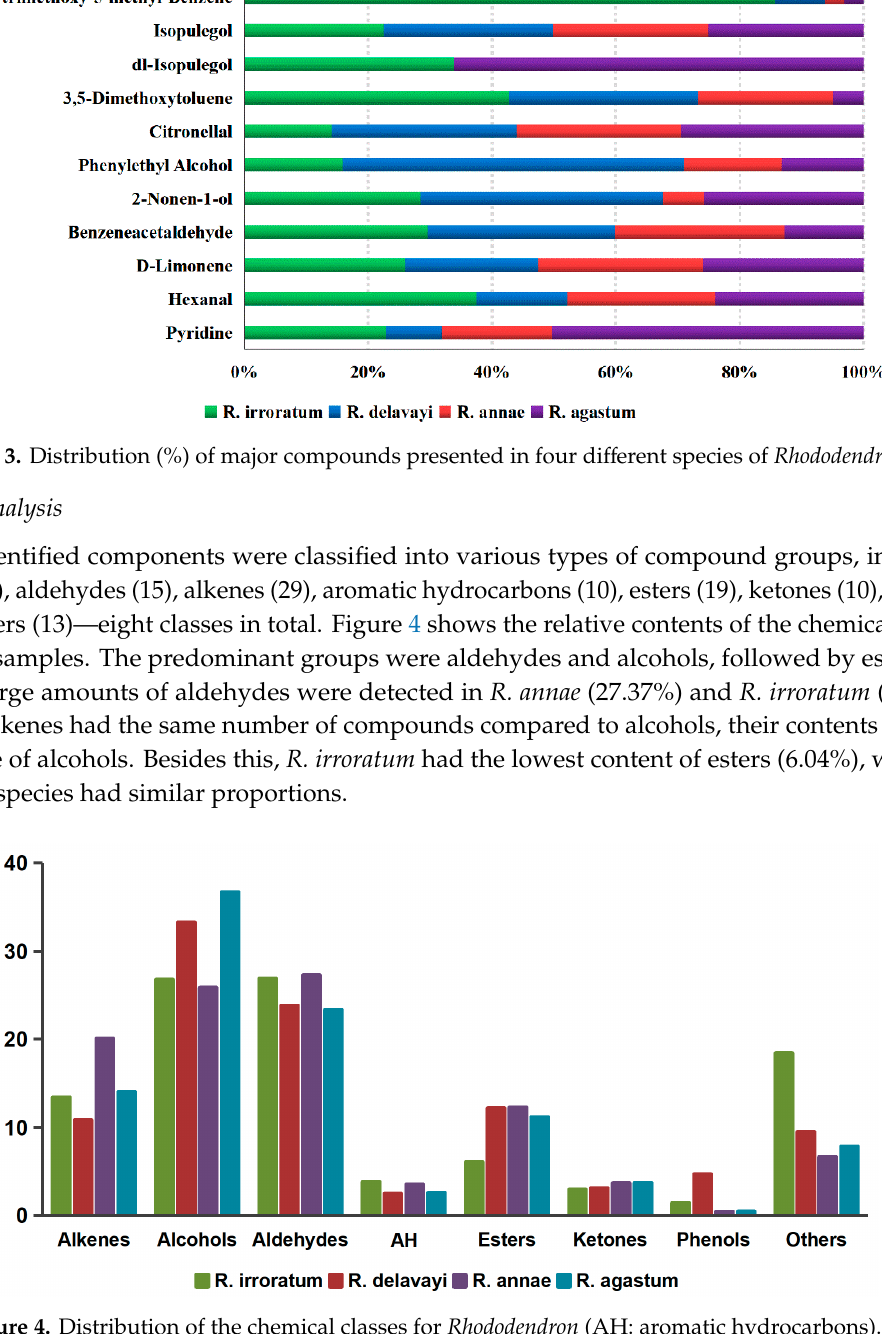
Figure 4. Distribution of the chemical classes for Rhododendron (AH: aromatic hydrocarbons).